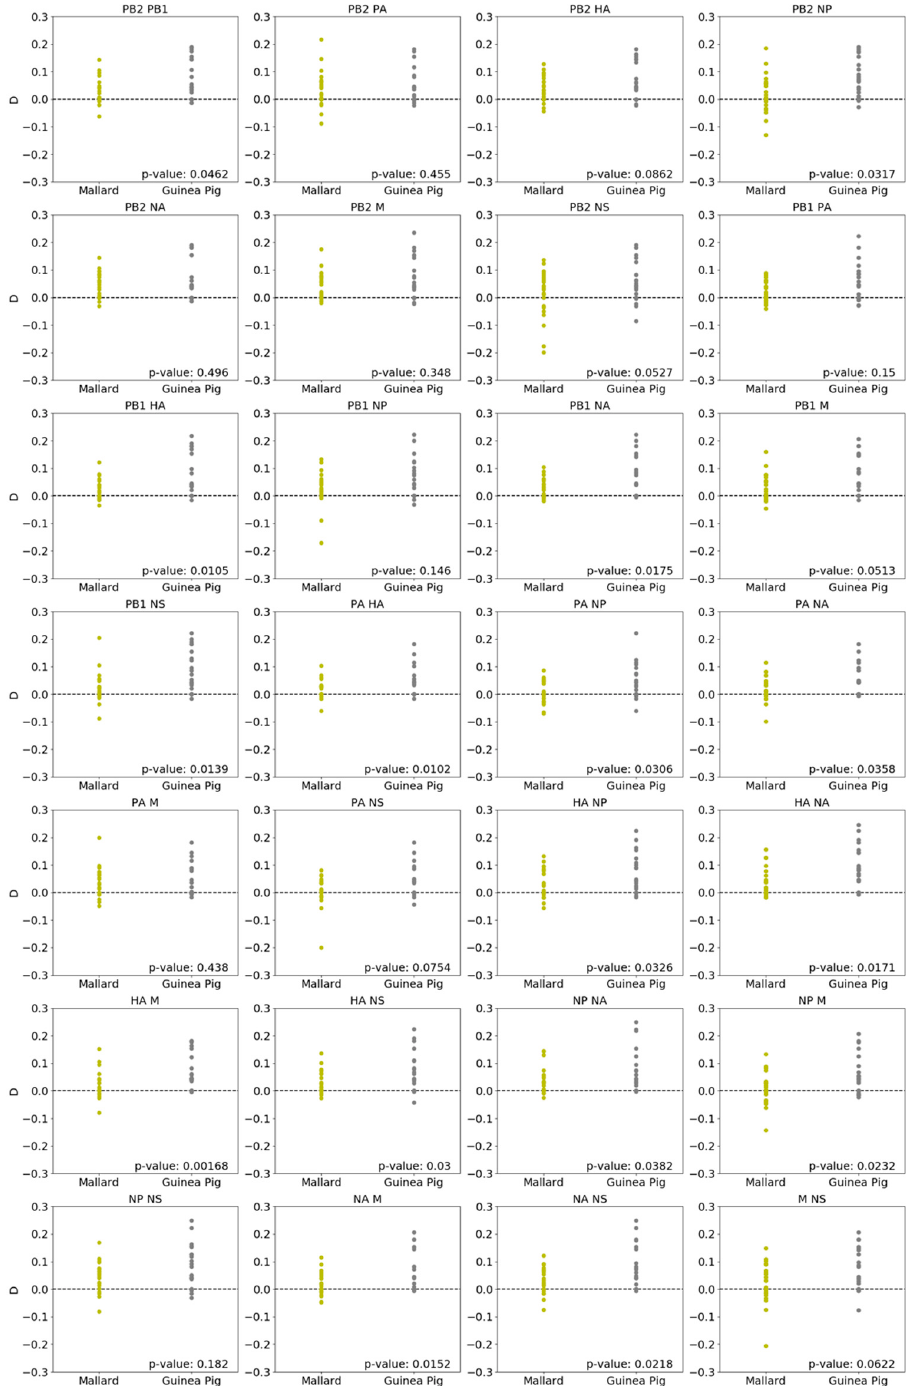
Figure 4. Pairwise linkage disequilibrium was typically lower in mallards than in guinea pigs. Linkage disequilibrium for each pairwise combination of influenza A virus (IAV) gene segments is shown. Each data point represents a mallard or guinea pig, with samples from all three time points aggregated for a given individual. p values indicate results of a Mann Whitney U test.